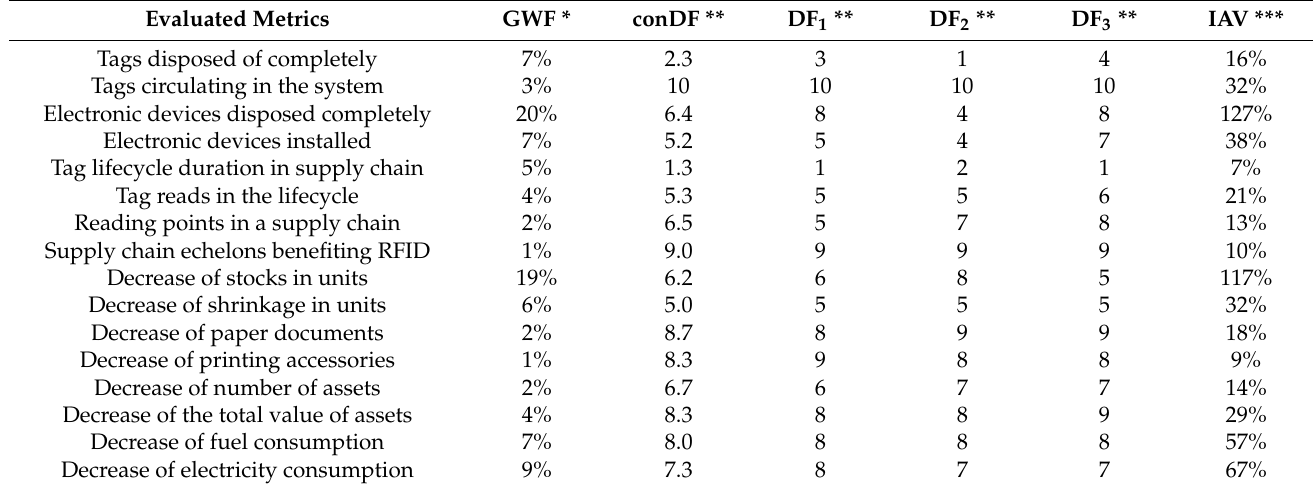
Table 6. Assessment of metrics for the considered